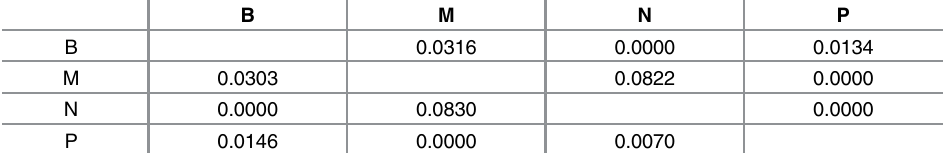
Table 11. Character transition likelihoods for custom parental care strategy character transition model. B